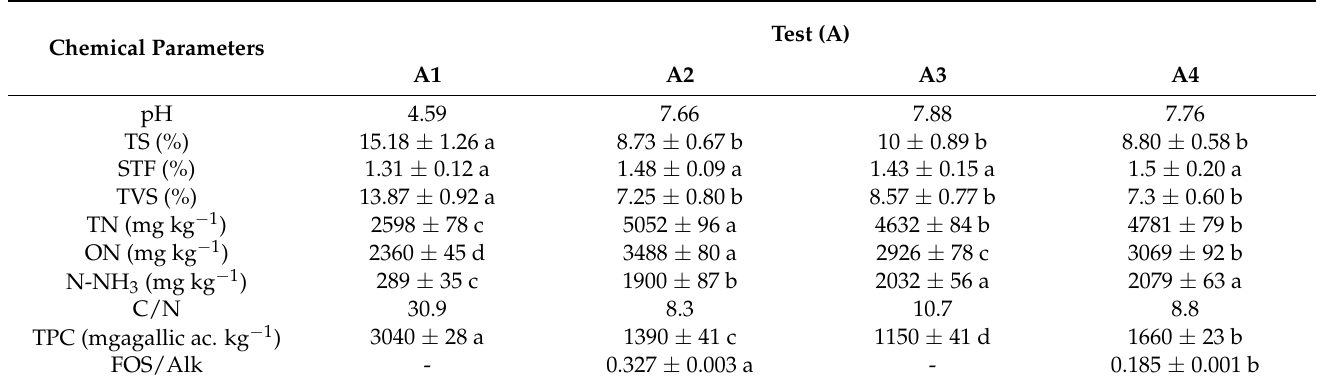
Table 2. Results of the chemical analyses of the evolving biomass of Test